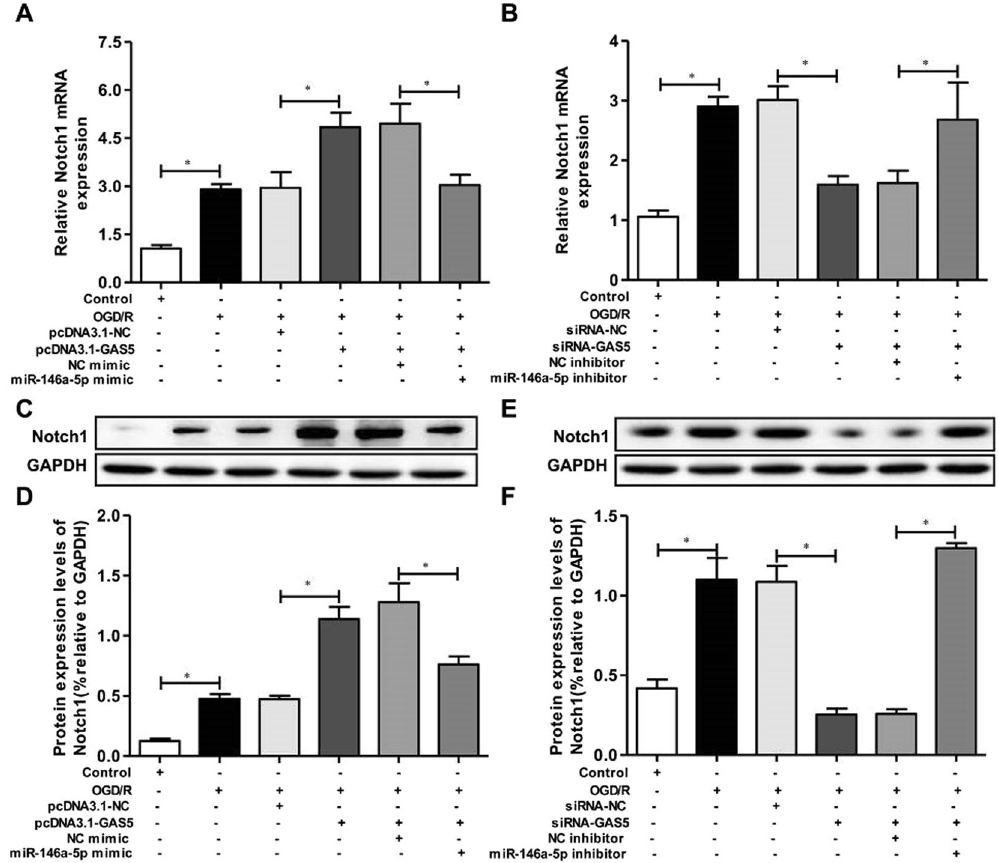
Figure 8. GAS5 regulate Notch1 expression by miR-146a-5p in OGD/R-induced BV2 microglia cells. ( A , C , D ) The mRNA and protein expression of Notch1 were decreased in OGD/R-induced BV2 microglia cells, and cell transfection of pcDNA3.1-GAS5 upregulated Notch1 expression in OGD/R-induced BV2 microglia cell line. However, miR-146a-5p mimic co-transfected into BV2 microglia cells reversed the effect of pcDNA3.1-GAS5 on Notch1 expression. ( B , E , F ) The mRNA and protein expression of Notch1 were decreased in BV2 microglia cells transfection of si-GAS5, but miR-146a-5p inhibitor co-transfected BV2 microglia cells reversed the Notch1 expression. Data are represented as mean ± SD, * P <